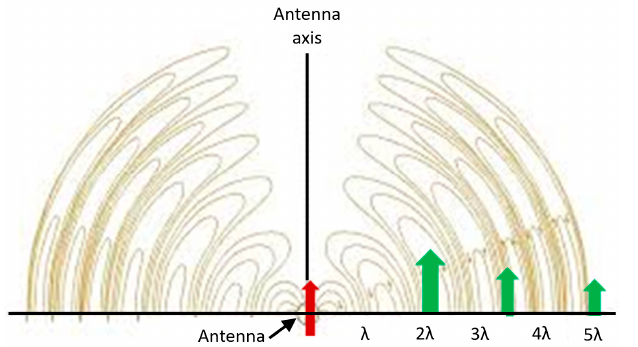
Figure 22. The radiation pattern of a dipole oscillator. The field on the axis is parallel to the dipole leading to enhancement.